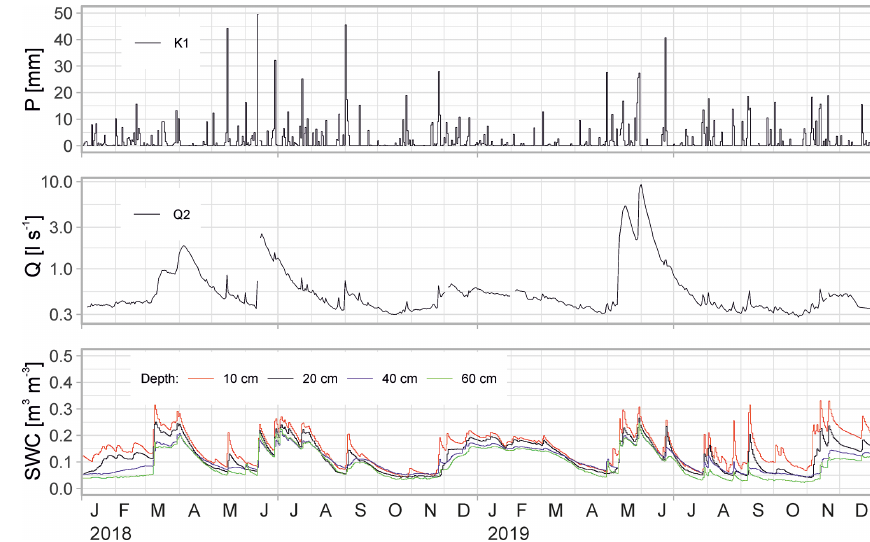
Figure 9. Daily soil water content and corresponding daily rainfall and log-discharge at site Q2S0 for 2018 to